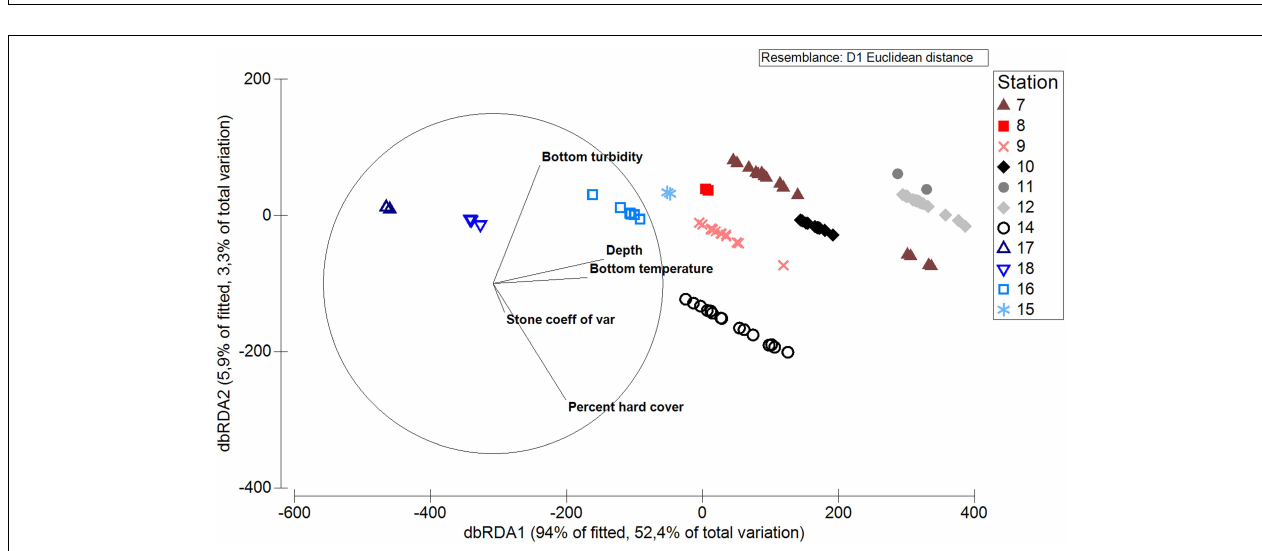
FIGURE 10 | dbRDA graph showing relationship of functional traits of north Svalbard fauna to abiotic factors.